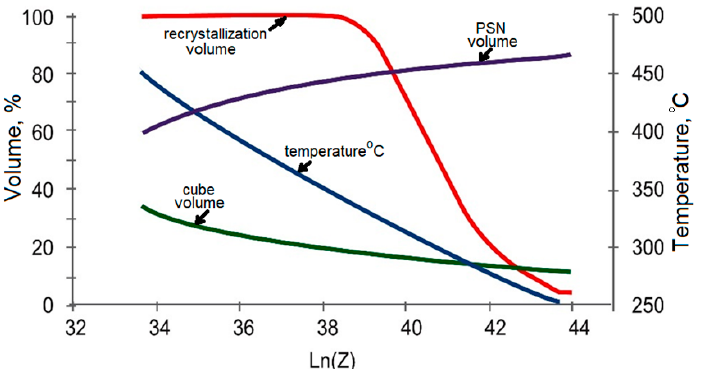
Figure 18. Dependences of the recrystallized volume, cube and random orientation (PSN) proportions on the Zener parameter for the AlMg 6 Mn 0.7 (1565 ch) alloy obtained during simulation.